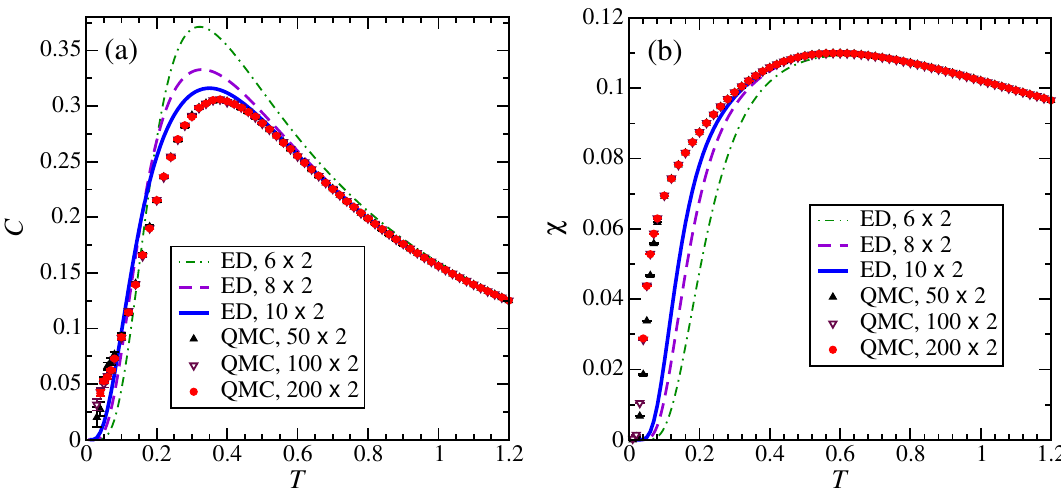
Figure 11: Magnetic specific heat, C , and susceptibility, χ , shown per spin for a ladder with rung coupling J ⊥ = 1, leg coupling J (cid:107) = 1, and diagonal coupling J × = 0.599. We compare QMC results obtained for ladders of L = 50, 100, and 200 rungs with ED results for L = 6, 8, and